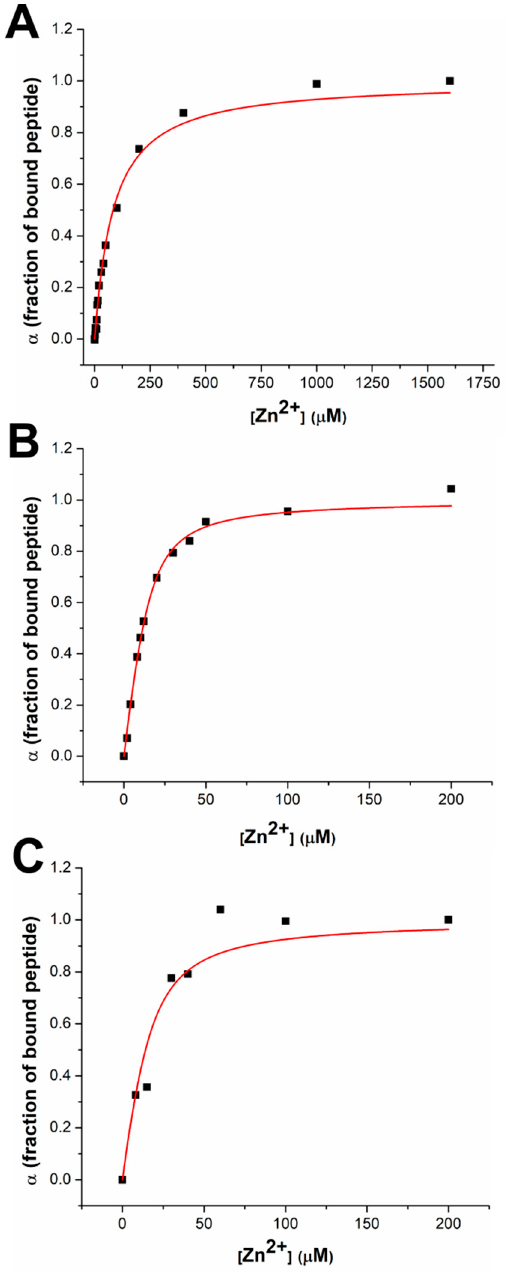
Figure 2. Zn(II) binding curves for peptides ( A ) dH3w(H3A), ( B ) dH3w(W6A), and ( C ) AcH3w. Binding curves were obtained by plotting the fraction of bound peptide ( α ) versus the Zn(II) concentration. K b values and stoichiometries derived from the fitting procedure are shown in Table 2. Table 2. Binding constant (K b ) and stoichiometry (n) for the Zn/peptide complexes.